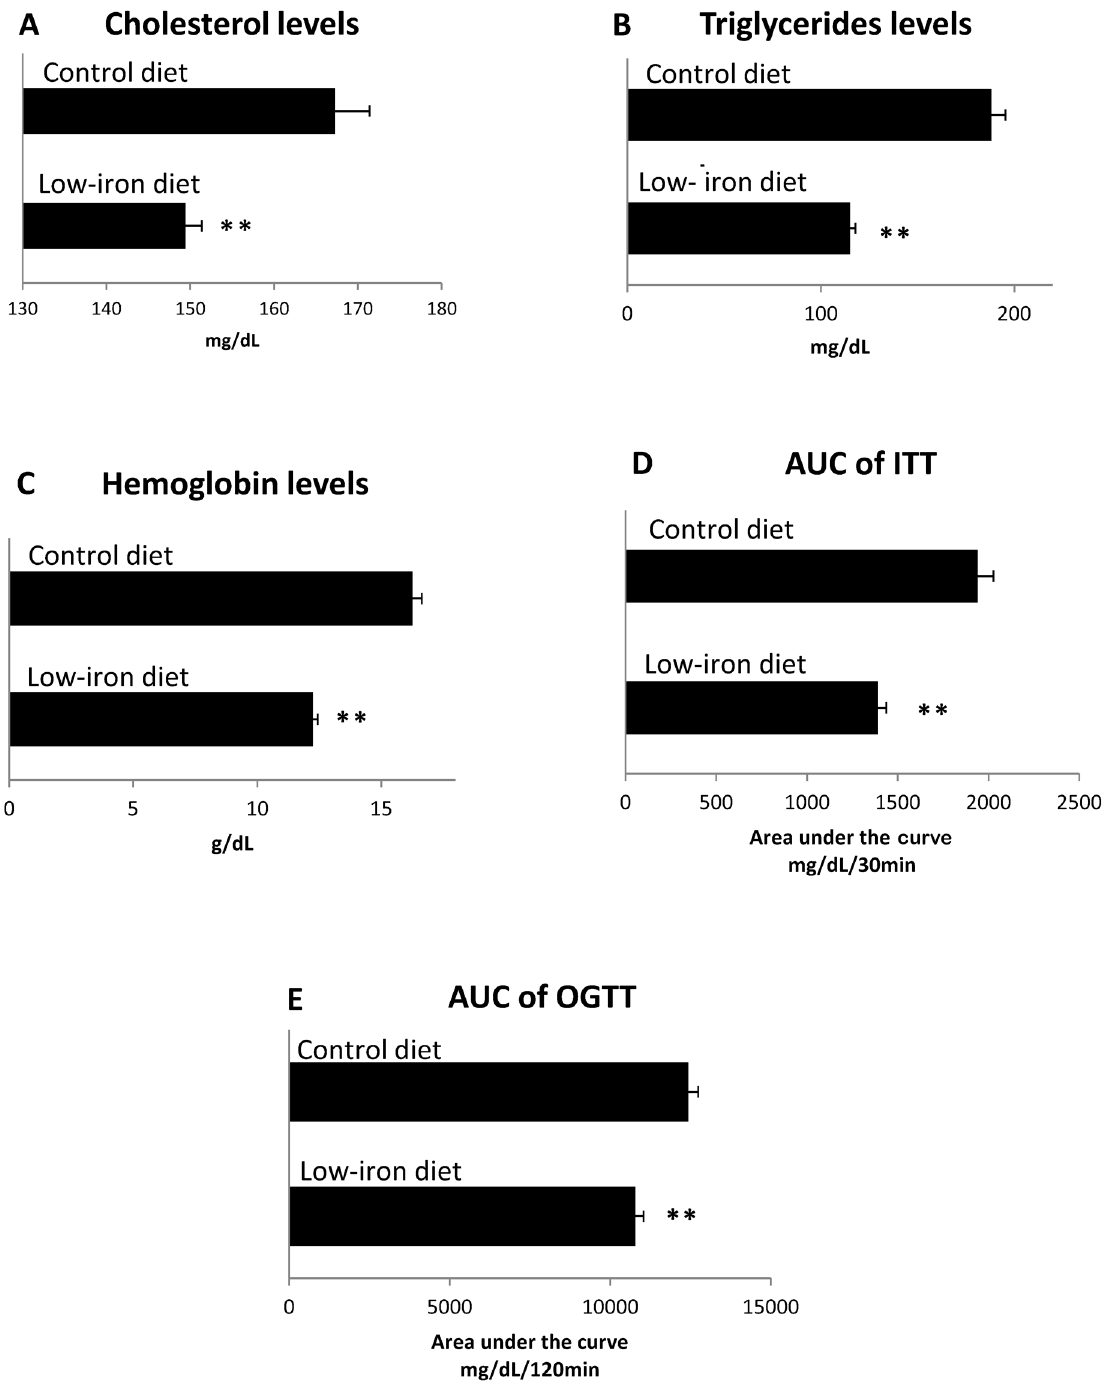
Fig 3. Effects of a low-iron diet on healthy rats. Healthy rats were analyzed after 8 weeks on a low-iron diet (n = 10), or control diet (n = 10). (A) Cholesterol levels. (B) Triglyceride levels. (C) Hemoglobin levels. (D) Area under the insulin tolerance test curve. E) Area under glucose tolerance curve. Bars represent the mean and standard error; p-values assessed with Student ’ s t-test; * p < 0.05, ** p < 0.001.